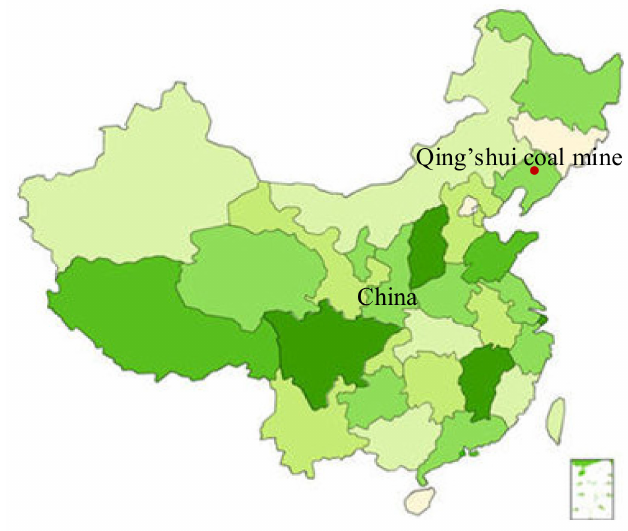
Figure 1. Location of the Qing’shui coal mine, Liaoning,